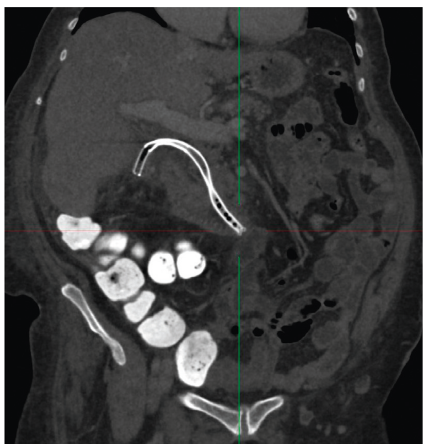
Figure 3: CT scan two days after stent insertion demonstrating appropriate positioning and relative size of the bare metal stents in the cystic and common bile